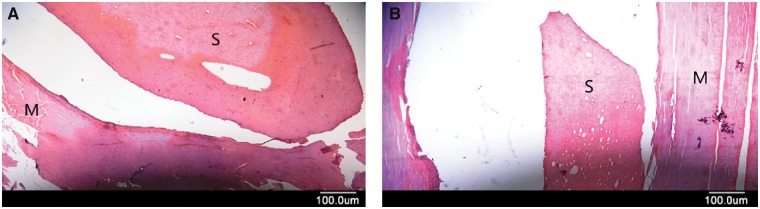
H&E staining of the implantation areas of β-TCP/CPC. (A) 4-week group. (B) 8-week group. M, muscle; S, scaffold material